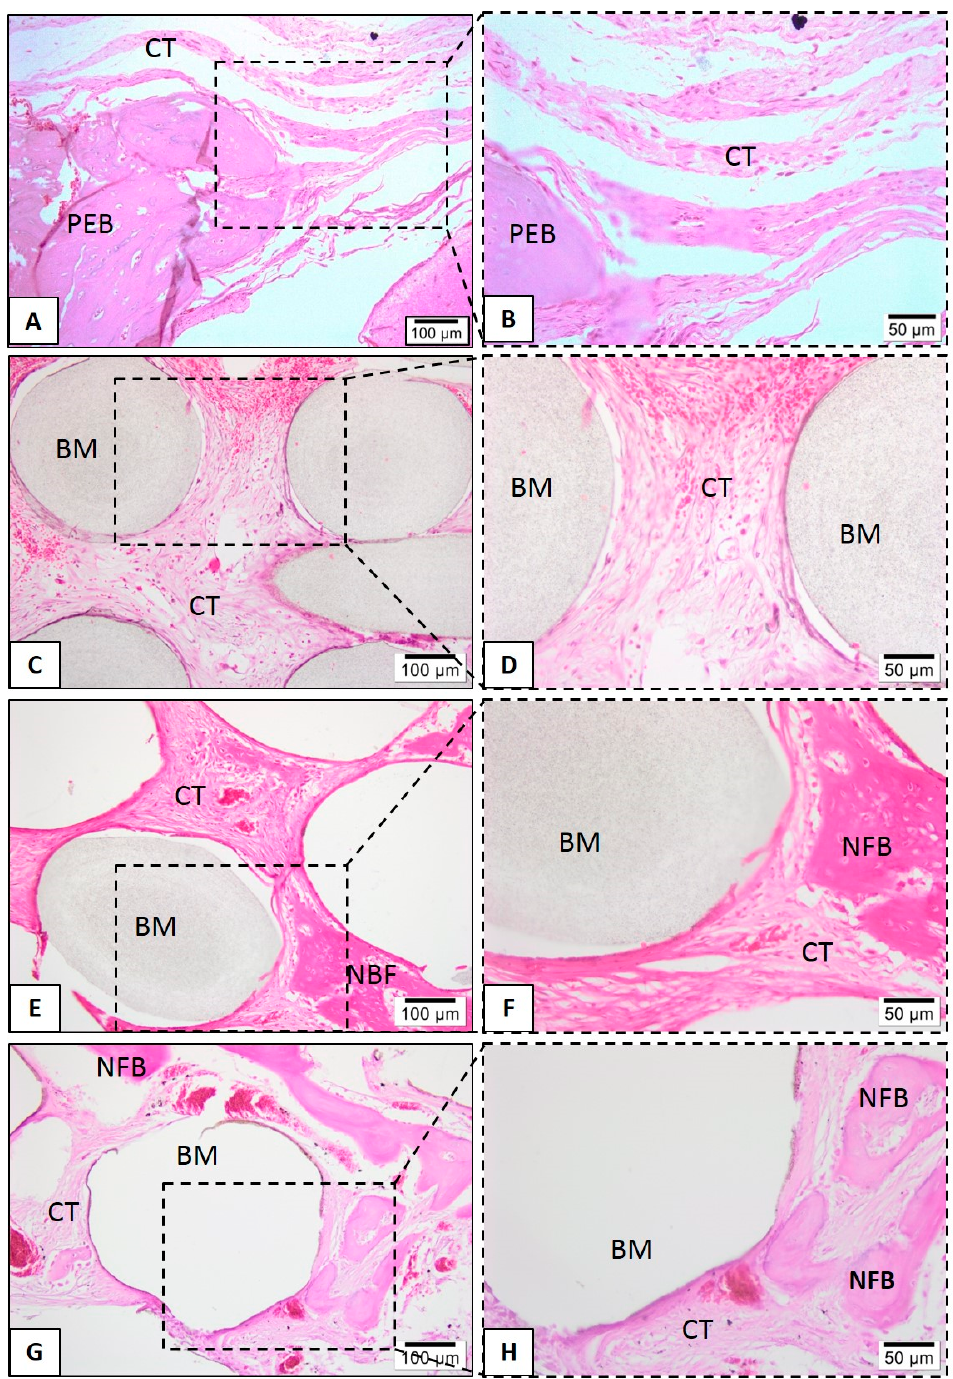
Figure 10. Representative photomicrographs of calvaria defect after 1 month. Histological section stained with hematoxylin/eosin from the region of control without biomaterial ( A , B ), biomaterial implantation in the PLA ( C , D ), PLA-CaP ( E , F ) and PLA-CaP-rhBMP-2 ( G , H ) groups—1 month after implantation. The region occupied by pre-existing bone is indicated with (PEB), newly formed bone (NFB); connective tissue (CT) and biomaterial/PLA scaffold (BM). Results are representative of 5